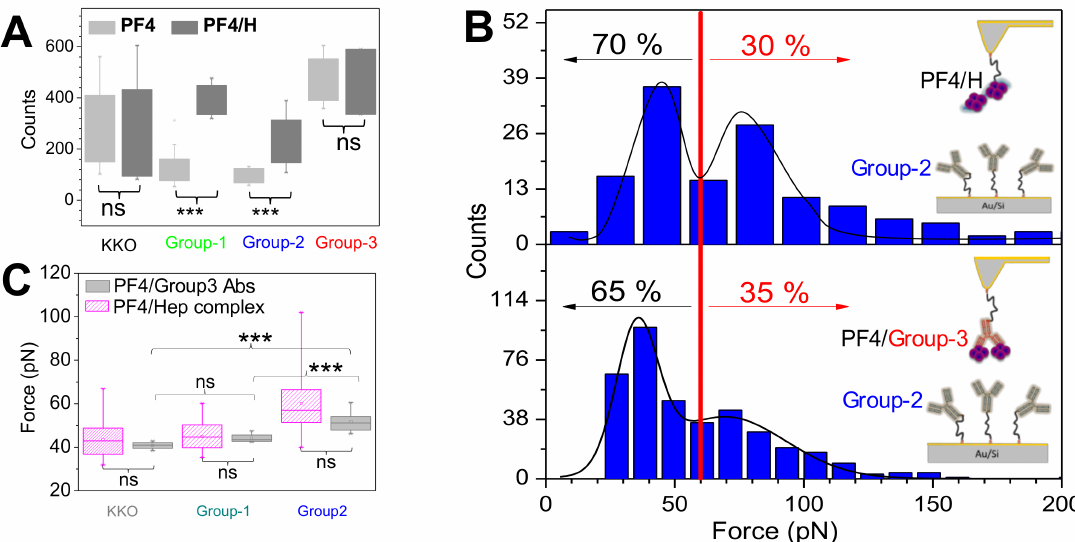
Figure 4. PF4/group-3 Abs complexes expose binding epitopes for other aPF4/H Abs. ( A ) Binding events when group-1 and group-2 Abs interacted with PF4 (light gray) was far different from those with PF4/H complexes (dark gray) while the standard KKO and group-3 Abs did not show a significant difference (ns). ( B ) The group-2 Abs immobilized on the substrates interacted with PF4/H complexes (top) showing a similar feature of force distribution as compared with that of the PF4/group-3 Abs complexes (bottom): ~70% of binding forces were ≤ 60 pN and ~30% of binding forces ≥ 60 pN. ( C ) The summary counts of interactions with binding forces >60 pN between either PF4/group-3 antibody complex (gray) or PF4/H complexes (pink) with KKO, group-1, or group-2 Abs again underscores that group-3 Abs can form complexes with PF4 which allow binding of other aPF4/H Abs. Statistic obtained by ANOVA tests show significant (***) or no significant (ns) difference. Adapted from